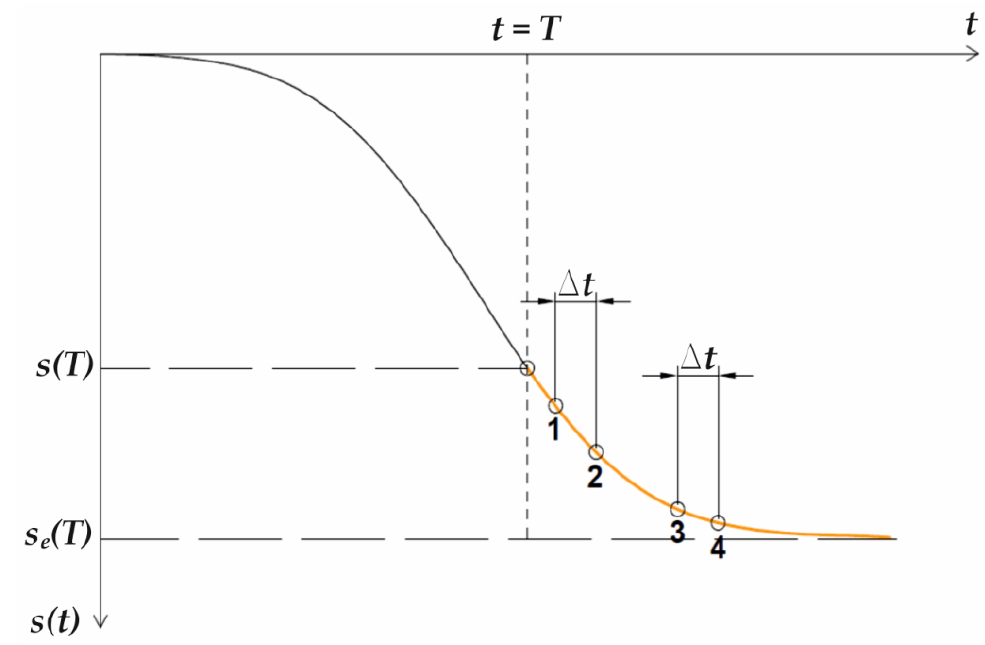
Figure 4. Subsidence calculation method for the four-point solution.